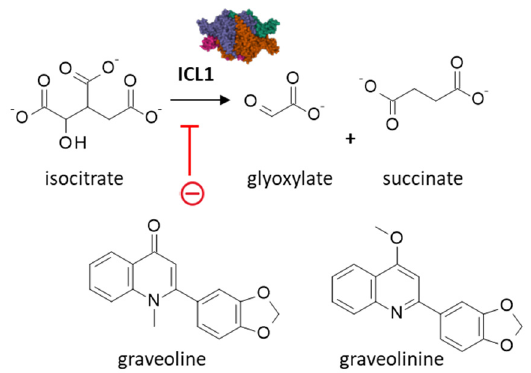
Figure 4. Graveoline is an inhibitor of isocitrate lyase 1 (ICL1) from the fungus Candida albicans [19]. The enzyme catalyzes the cleavage of isocitrate to succinate and glyoxylate. The analogue graveoline is not active against ICL1 but displays antiangiogenic properties. These two quinoline alkaloids can be found in Ruta species, including R. angustifolia Pers.